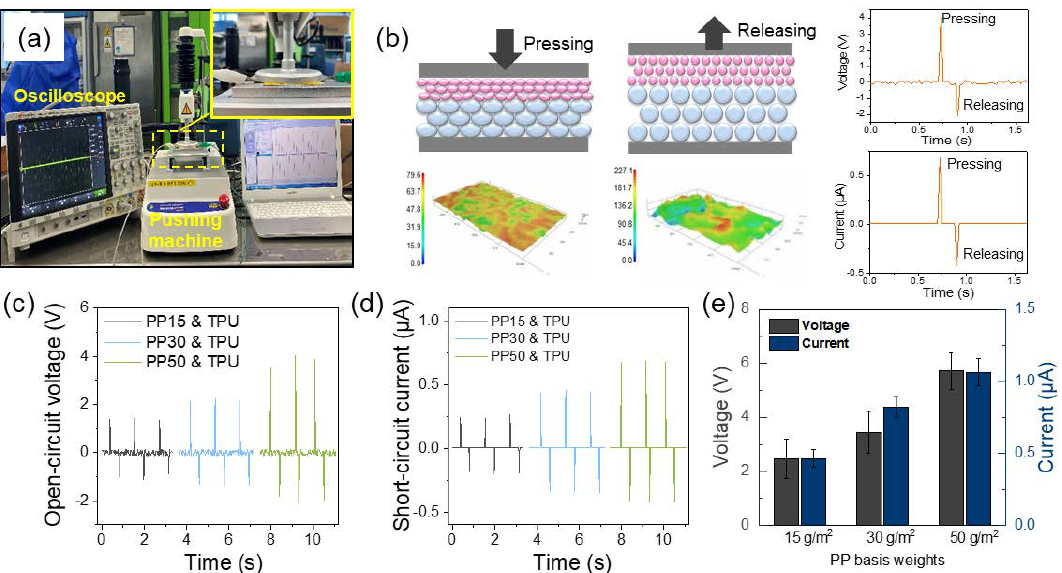
Figure 3. ( a , b ) Schematic illustration of the change in the fiber contact area of a compressed and decompressed nonwoven based N-TENG; ( c ) open-circuit voltage and ( d ) short-circuit current of the porous TPU / PP nonwoven TENGs with di ff erent basis weights of PP; ( e ) the average output voltage and current of each specimen over 100